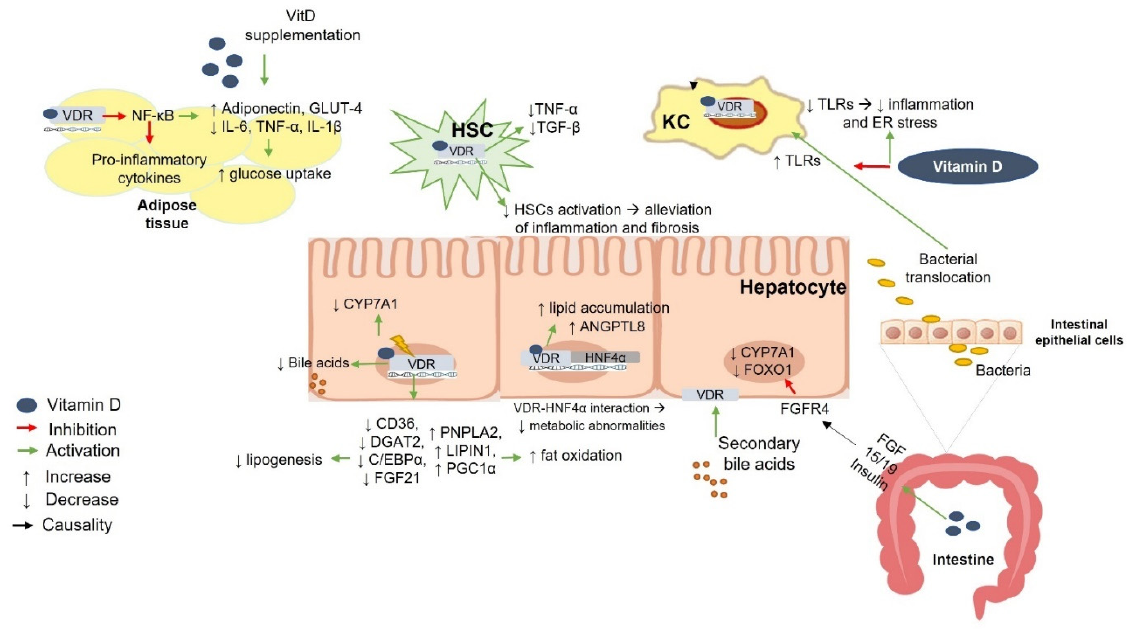
Figure 5. Vitamin D–VDR-mediated effects on nonalcoholic fatty liver disease (NAFLD). Vitamin D acts on adipose tissue by inhibiting NF- κ B transcription and suppressing the expression of inflammatory cytokines. Higher adiponectin secretion improves insulin resistance by promoting transcriptional regulation and translocation of GLUT4 into adipocytes, leading to improved glucose uptake. Increased gut permeability leads to translocation of bacteria, which in turn induce TLRs on KCs. Vitamin D suppresses the expression of TLRs in KCs and reduces inflammation. Binding of vitamin D to VDR leads to reduced proliferation of HSCs, thereby contributing to the alleviation of liver fibrosis. Co-localization of VDR with HNF4 α in the nucleus ameliorates metabolic abnormalities. Vitamin D upregulates intestinal FGF15 (human ortholog FGF19), which phosphorylates hepatic FGFR4 in the liver to inhibit CYP7A1. Insulin and FGF15/19 suppress FOXO1, a key mediator of the FGF and insulin pathways, contributing to bile acid and glucose metabolism. Stimulation of VDR accelerates lipid accumulation in the liver and increases the expression of ANGPTL8, a key modulator of triglyceride metabolism. The deletion of VDR and apolipoprotein E results in decreased gene expression of CD36, DGAT2, C/EBP α , and FGF21 and increased expression of PNPLA2, LIPIN1, and PGC1 α in mouse livers. VDR, vitamin D receptor; TLR, toll-like receptor; ER, endoplasmic reticulum; GLUT4, glucose transporter 4; FGF15/19, fibroblast growth factor 15/human ortholog 19; FGFR4, FGF receptor 4; FOXO1, forkhead transcription factor 1; CYP7A1, cholesterol 7a-hydroxylase; HNF4 α , hepatocyte nuclear factor 4 α ; ANGPTL8, angiopoietin like 8; CYP27B1, cytochrome P450, family 27, subfamily B, polypeptide 1; HSC, hepatic stellate cells; KC, Kupfer cell; NF- κ B, nuclear factor- κ B; IL-, interleukin; TNF- α , tumor necrosis factor α ; TGF- β , transforming growth factor beta; CD36 (cluster of differentiation 36); DGAT2, diacylglycerol O-acyltransferase 2; C/EBP α , CCAAT/enhancer binding protein α ; FGF21, fibroblast growth factor 21; PNPLA2, patatin-like phospholipase domain-containing protein 2; PGC1 α , peroxisome-proliferator-activated receptor gamma coactivator 1-alpha. The binding of vitamin D to VDR results in the decreased proliferation of HSCs and contributes to the alleviation of liver fibrosis [25] (Figure 5). The interaction and co-